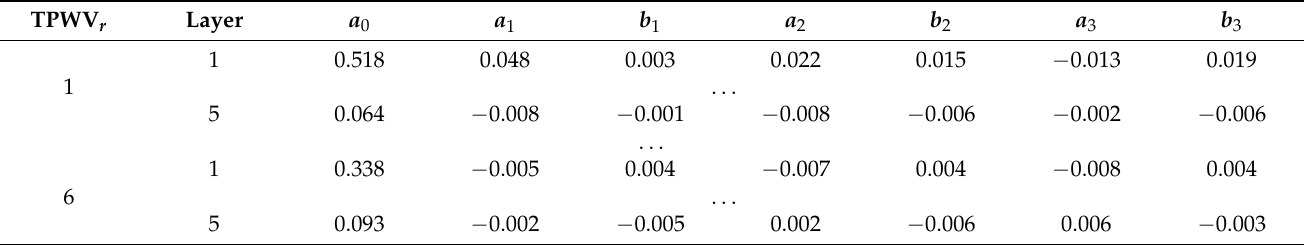
Table 1. Coefficients of the IRPWV model for the selected layers, i.e., 1 and 5 layers, within the se- lected TPWV r , i.e., TPWV r 1 and 6, at KOWLOON station; more details are shown in Table